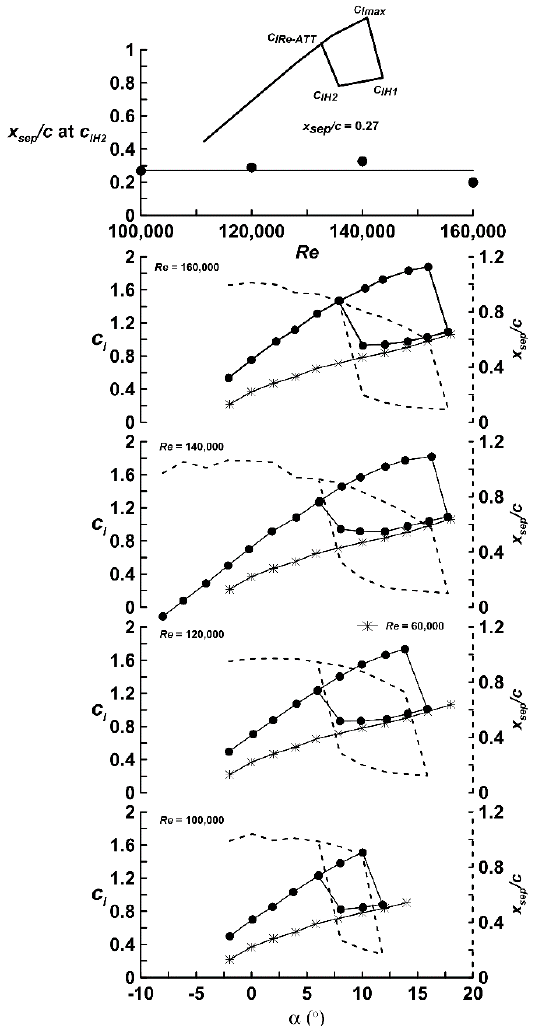
Figure 1. Effect of Re on measured c l and calculated separation location, E591 airfoil.